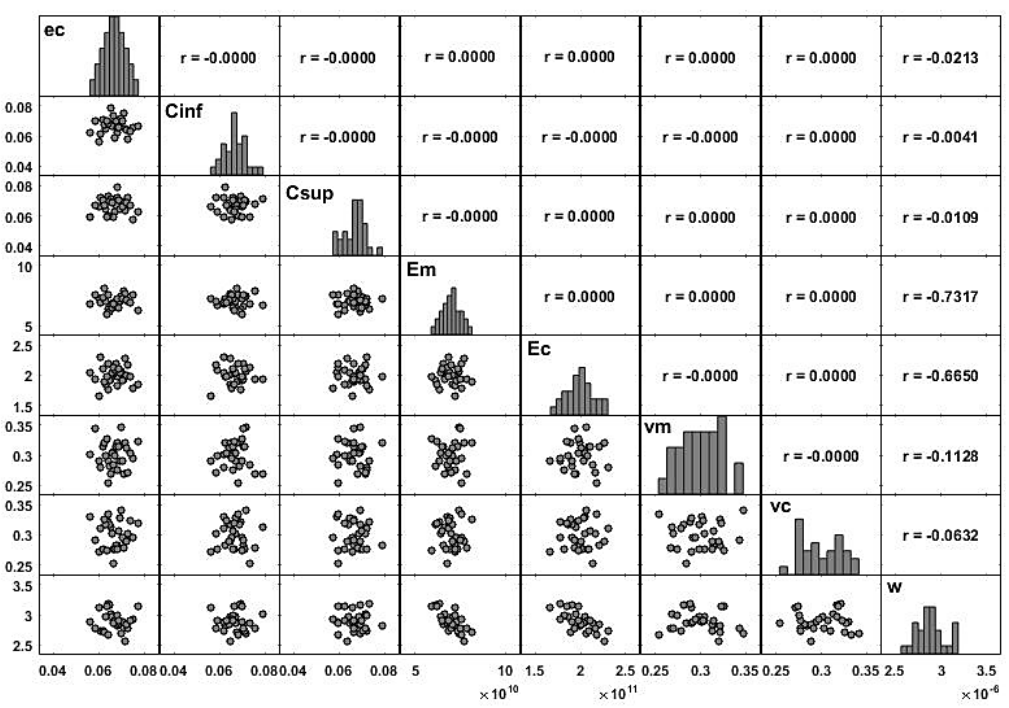
Figure 6. Matrix plot of the modeling parameters (inputs and output): case 3.2.2 — Thinner core.